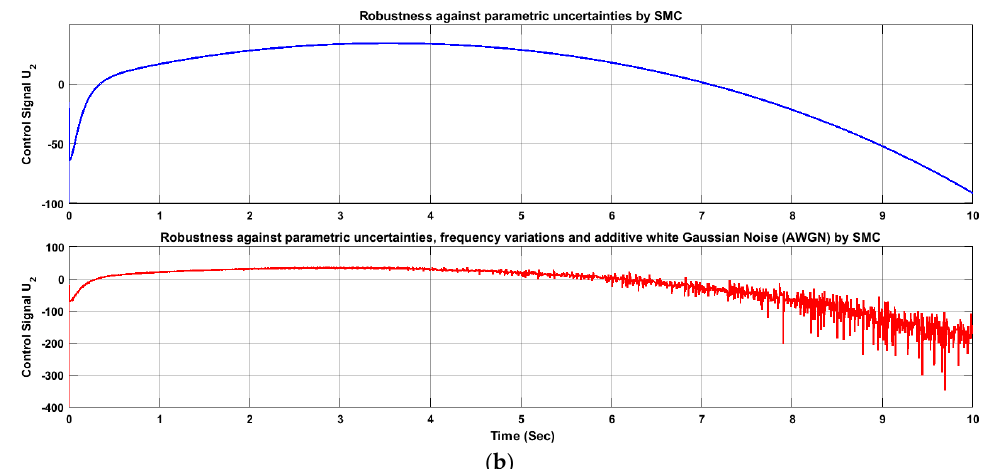
Figure 18. ( a ) d-axis current compensation (d-axis control signal) comparison; and ( b ) q-axis current compensation (q-axis control signal) comparison, between robustness analysis against parametric variation and robustness analysis against parametric uncertainties, frequency variation and additive Gaussian noise using SMC control technique based on boundary condition.